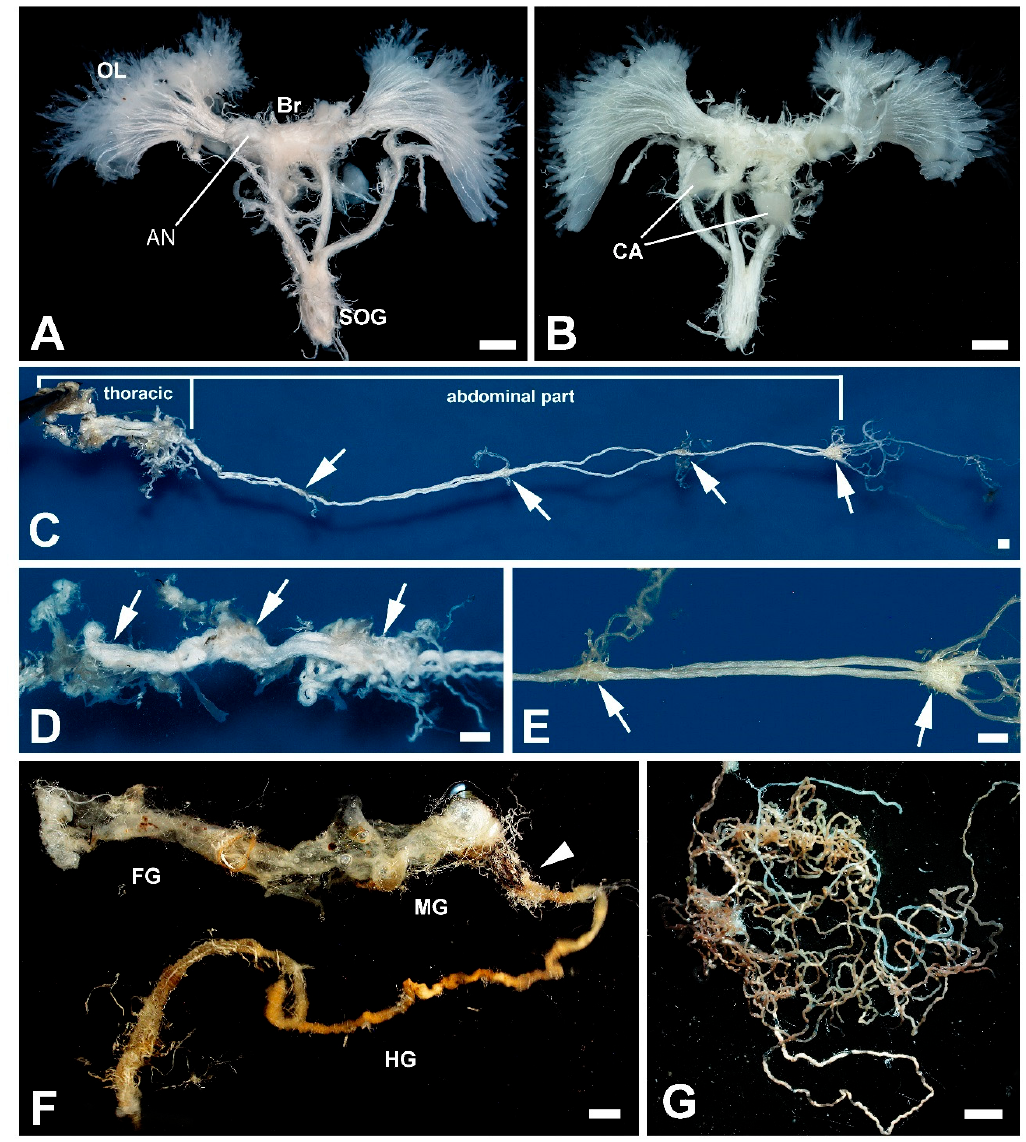
Figure 6. T. giganteus , central nervous and digestive systems. ( A , B )—Anterior and posterior view of the cephalic ganglion, respectively. AN, antennal nerve; Br, brain; CA, corpora allata, OL, optic lobe, SOG, subesophageal ganglion. ( C )—Ventral nerve cord divided to the thoracic and abdominal part. The arrows show ganglia in the abdominal part. ( D )—The detail image of thoracic part of the ventral nerve cord. The arrows show ganglia. ( E )—The detail image of posterior region of the abdominal part of the ventral nerve cord. The arrows show ganglia. ( F )—The empty gut. FG, foregut; MG midgut; HG, hindgut. The white arrowhead shows the place where the Malpighian tubules are attached. ( G )—Malpighian tubules. Scale bar: 1 mm.